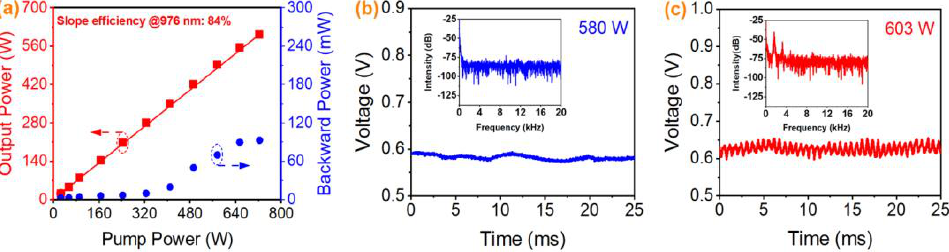
Figure 2. ( a ) Output power and backward propagating power versus pump power. Signals in temporal intensity. Inset: corresponding Fourier spectra. ( b ) At 580 W. ( c ) At 603 W.